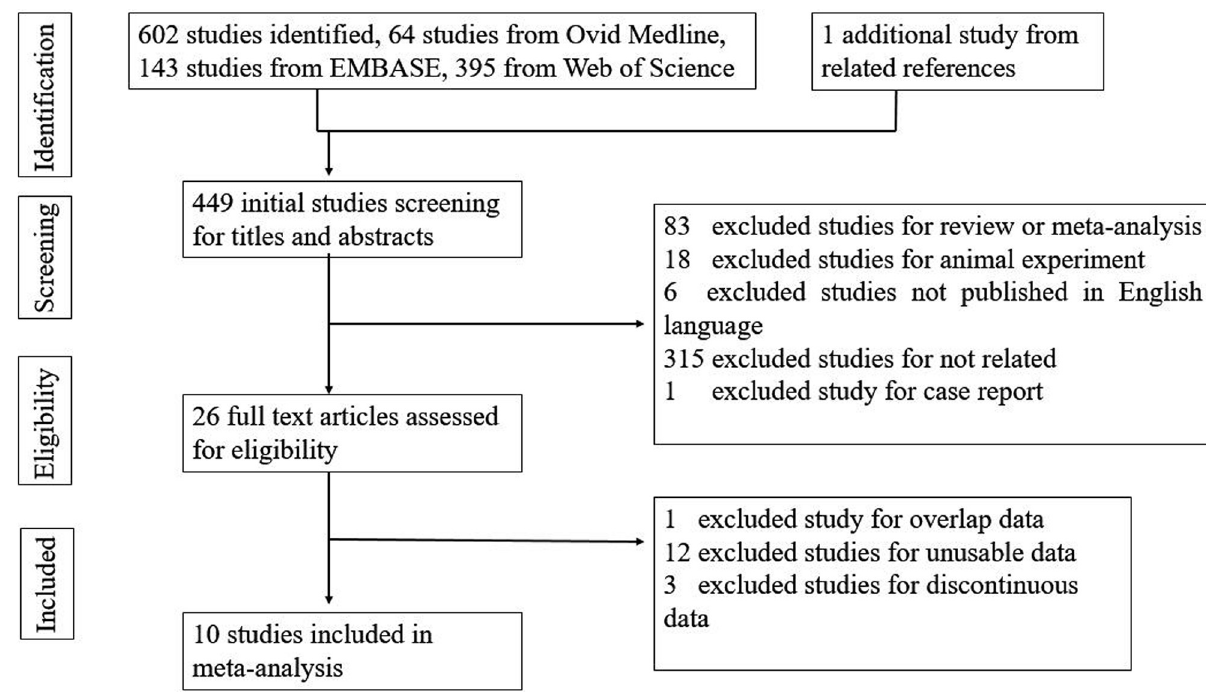
Fig 1. Flow chart for study selection.